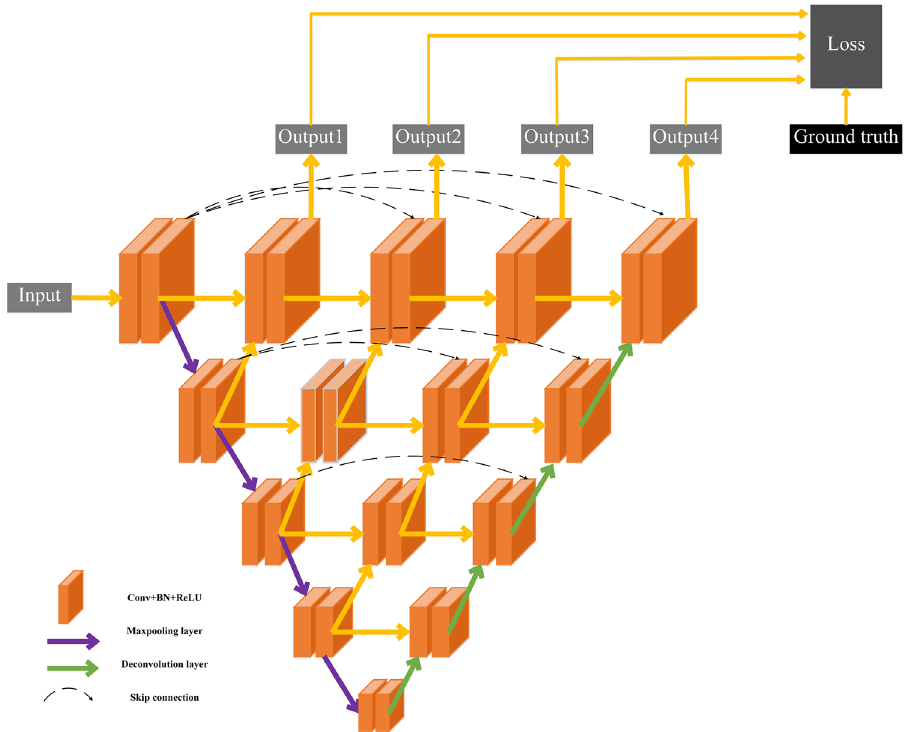
Figure 3. The architecture of deep supervision U-net++ . U-net++ consisted of an encoder with four downsampling stages and decoder path with four corresponding upsampling stages. In the U-net++ model, 3 × 3 kernel was used for all convolutional and deconvolution layers with strides 1 and 2, respectively. All convolutional layers were followed by a batch normalization (BN) layer and ReLU activation function. The number of feature maps doubled at each stage of the encoder path and halved at each decoder stage. Nested and dense convolution layers whose number of convolution layers depends on the pyramid level were added between encoder and decoder